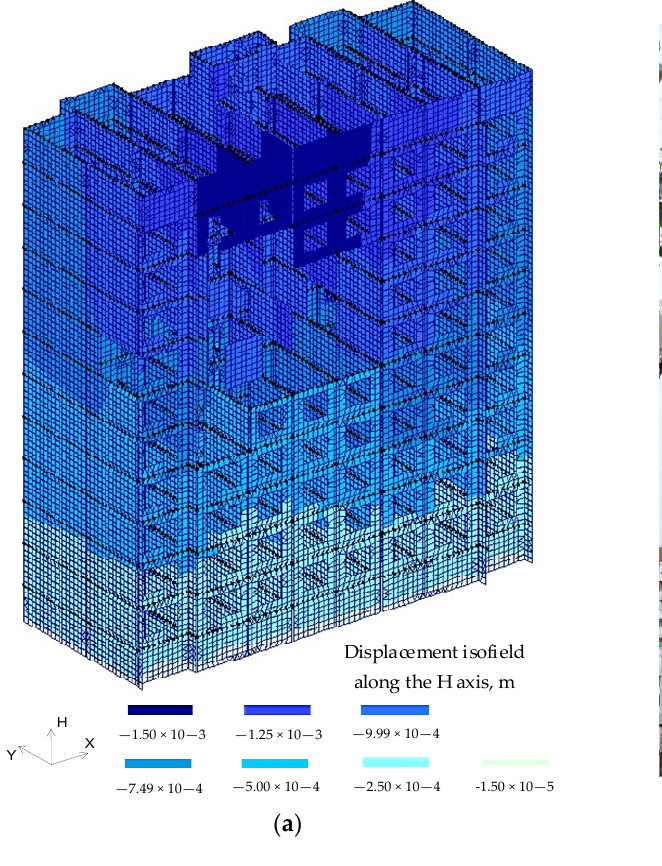
Figure 9. The results of frame deformation predictions of a large-panel building ( a ) and the scheme of the placement of observation points to the deformations of the structures ( b ) (Kyiv city, S.Krush-